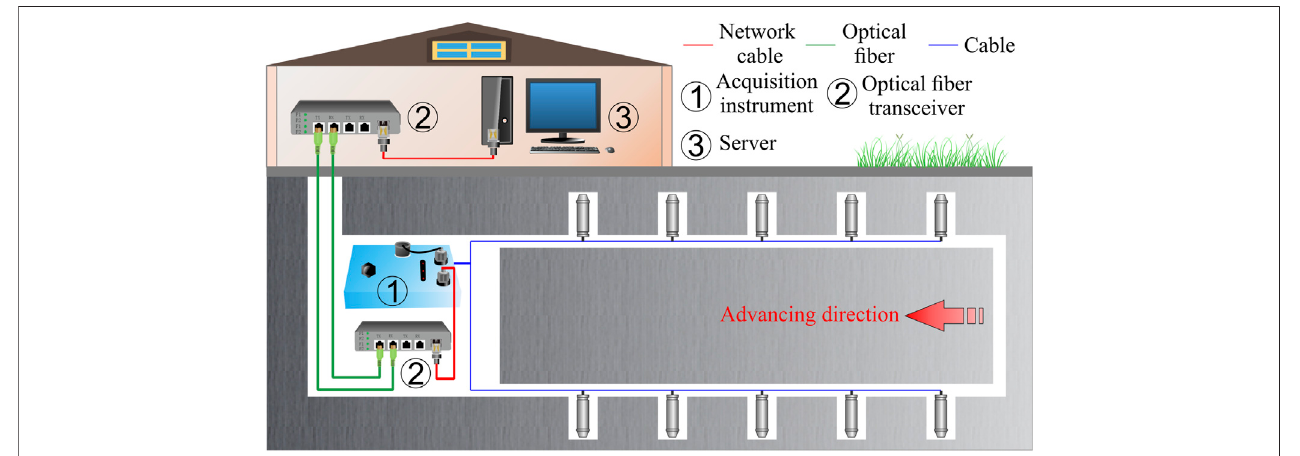
FIGURE 2 | Sketch map of microseismic monitoring system in Xiqu Coal Mine.